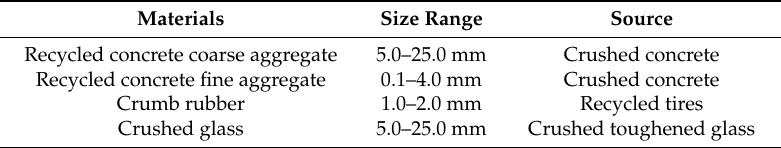
Figure 1. Recycled wastes. ( a ) RCCA; ( b ) RFCA; ( c ) crumb rubber; ( d ) crushed glass; ( e ) GGBS. Table 2. Size range and sources of construction wastes.